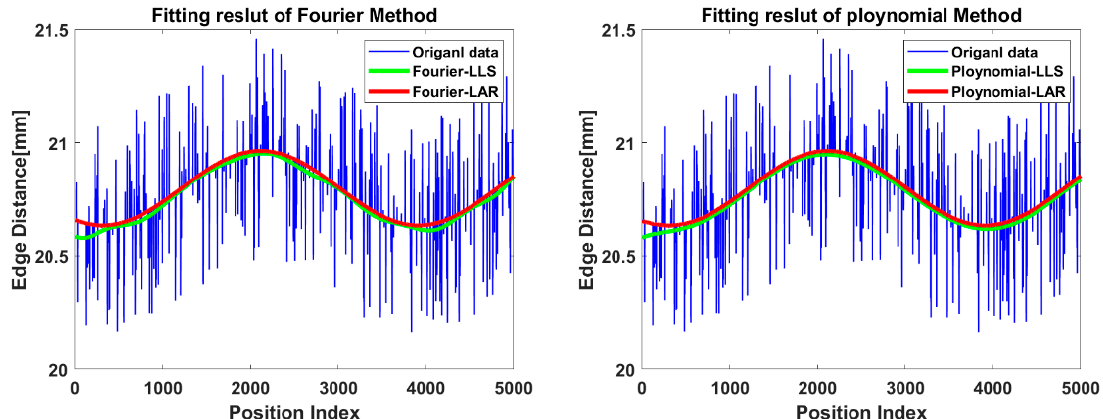
Figure 11. The fi tt ing edge distance results of di ff erent methods. Figure 11. The fitting edge distance results of different